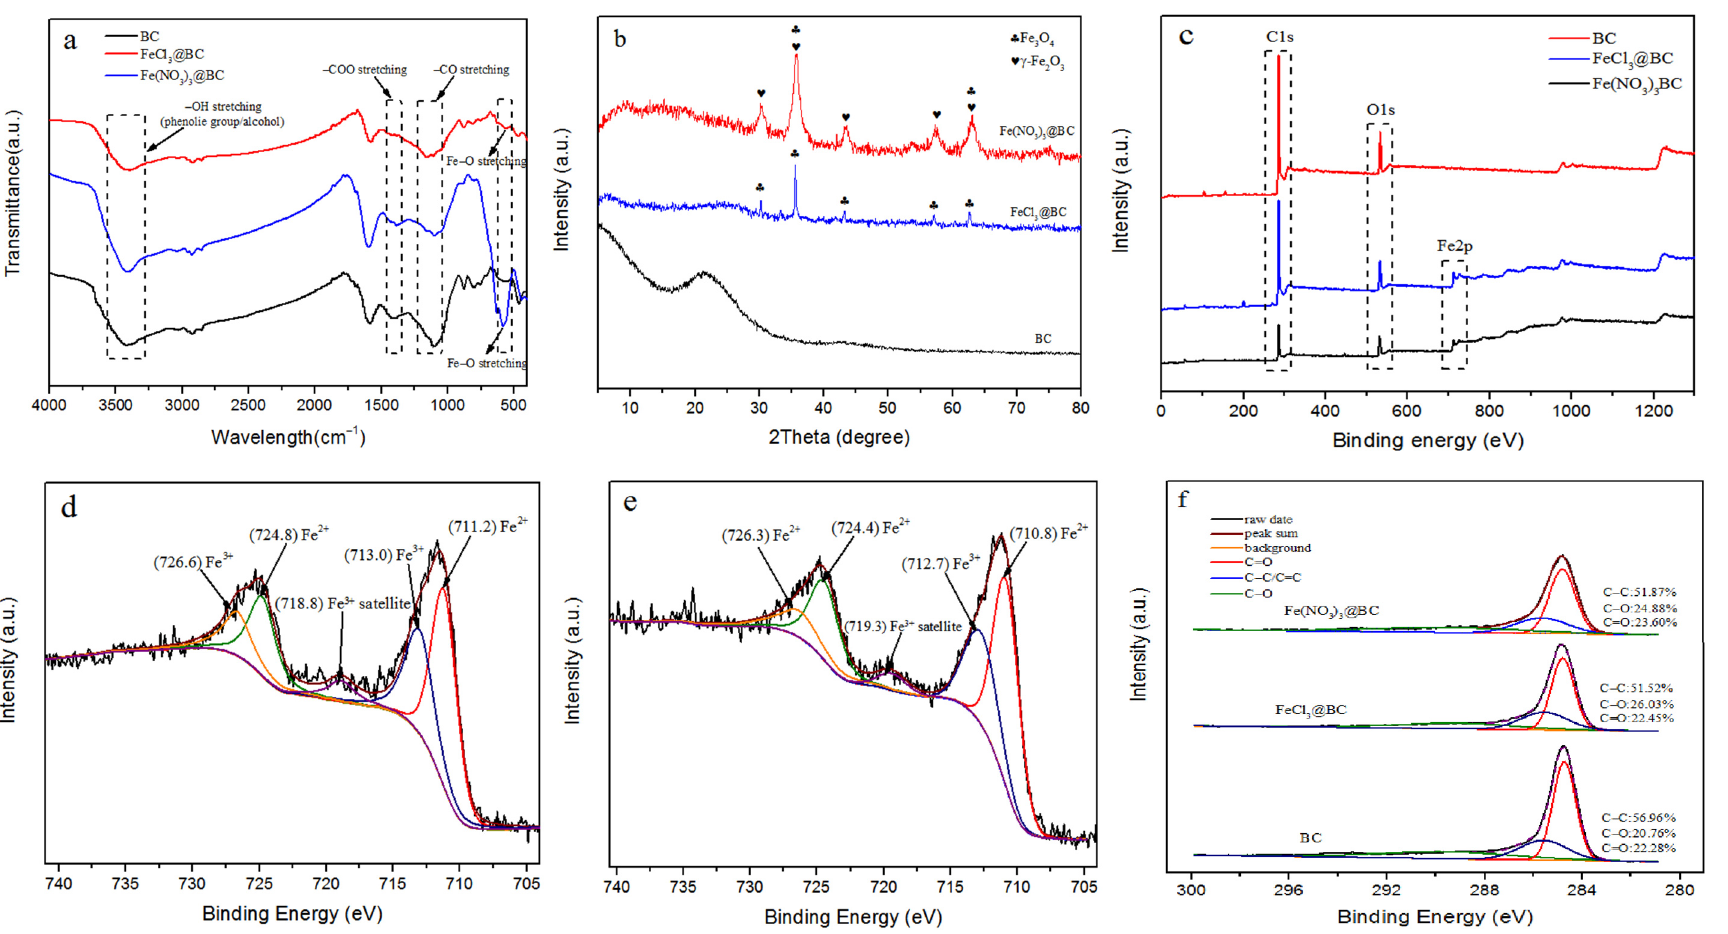
Figure 3. The comparative spectra of BC of FeCl 3 @BC and Fe(NO 3 ) 3 @BC as revealed by FTIR ( a ), XRD ( b ) and XPS ( c ). XPS Fe2p spectra of FeCl 3 @BC ( d ) and XPS Fe 2p spectra of Fe(NO 3 ) 3 @BC ( e ), XPS C1s spectra of BC, of FeCl 3 @BC and Fe(NO 3 ) 3 @BC ( f ).